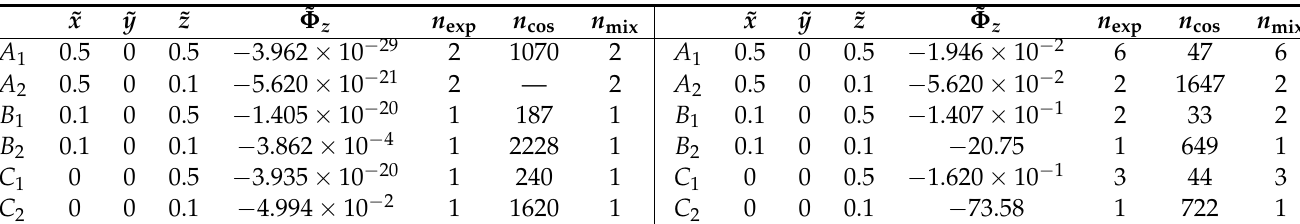
Table 5. Numerical values of the z -component of the rescaled force ˜ Φ z ≡ ∂ ˜ Φ / ∂ ˜ z as well as the numbers n exp , n cos and n mix for points A 1 , A 2 , B 1 , B 2 , C 1 and C 2 for ˜ λ eff = 0.01 and ˜ λ eff = 0.1 in the left and right tables, respectively. ˜ x ˜ y ˜